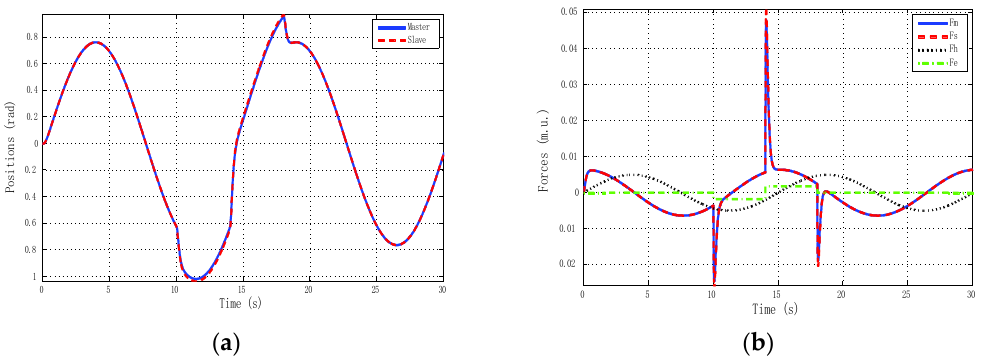
Figure 8. Simulated sine reference force: γ-4C control scheme with h max = 0, d = 0. ( a ) Positions; ( b ) Forces.